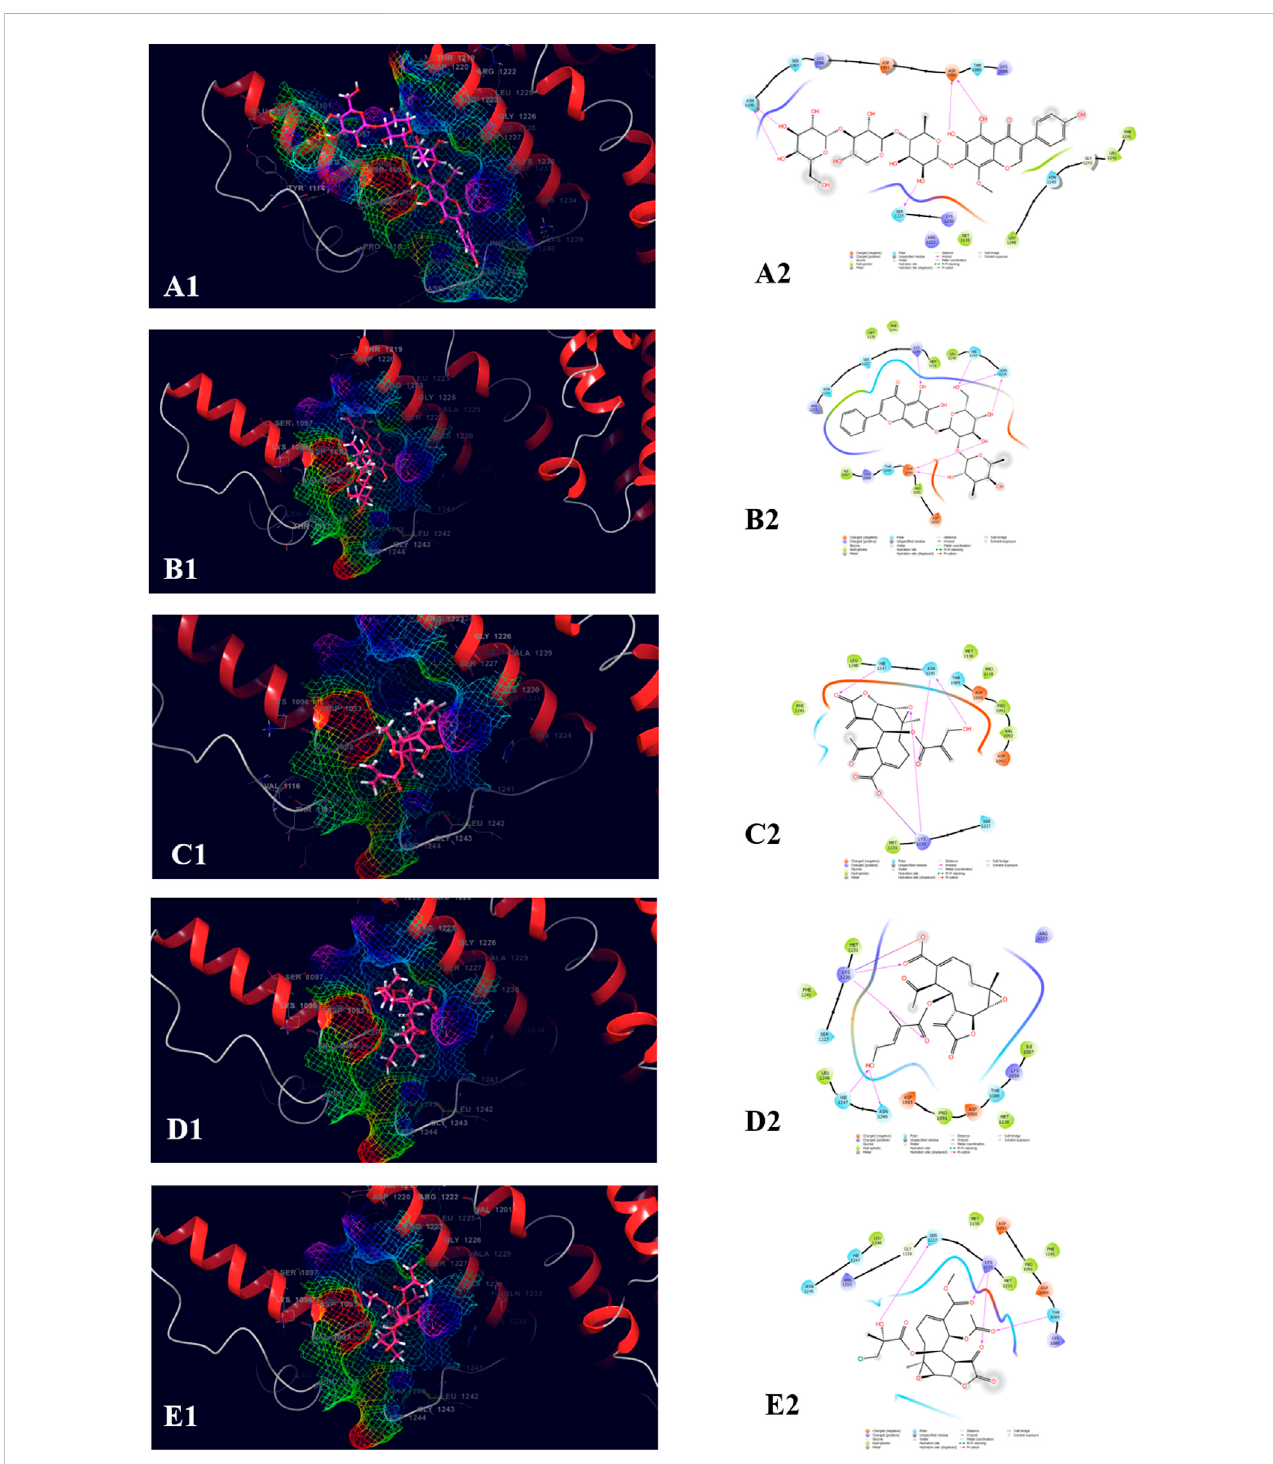
FIGURE 7 Molecular docking interactions of metabolites in the binding pocket of PDB ID: 3FAY. [3D and 2D representation of 4 ′ ,5,6,7-Tetrahydroxy-8- methoxyiso fl avone-7-O-beta-D-galactopyranosyl-(1 → 3)-O-beta-D-xylopyranosyl-(1 → 4)- O-alpha-L-rhamnopyranoside (A1,A2) , Baicalein-7-O- diglucoside (B1,B2) , 8-Desacylenhydrin-4-hydroxymethacrylate (C1,C2) , 8-Desacylenhydrin-4-hydroxytiglate (D1,D2) , and 8-Deepoxyangeloyl-8-2- hydroxy-3-chloro-isobutyroyl-enhydrin (E1,E2) in the binding pocket of PDB ID: